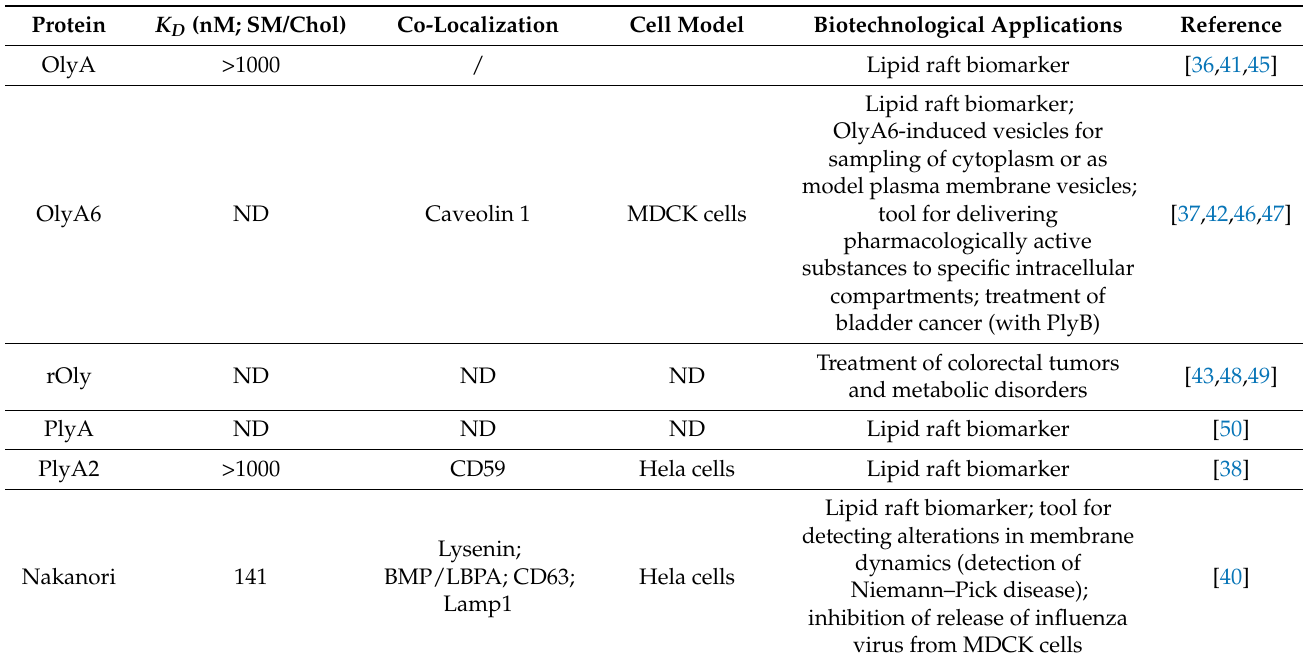
Table 2. The main characteristics of the mushroom lipid raft binding proteins.